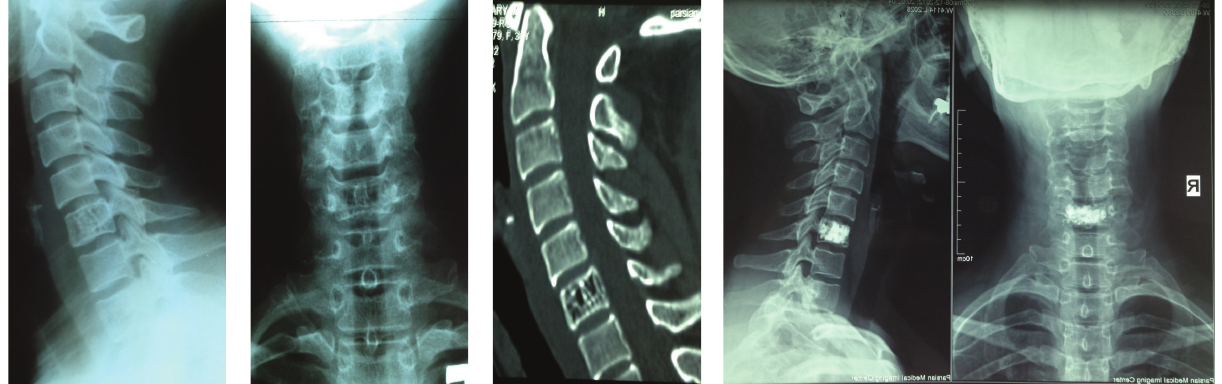
Figure 1: A 32-year-old woman presented with chronic unremitting neck pain. Aggressive hemangioma of C6 vertebra was verified on imaging scans. She was treated with anterior percutaneous